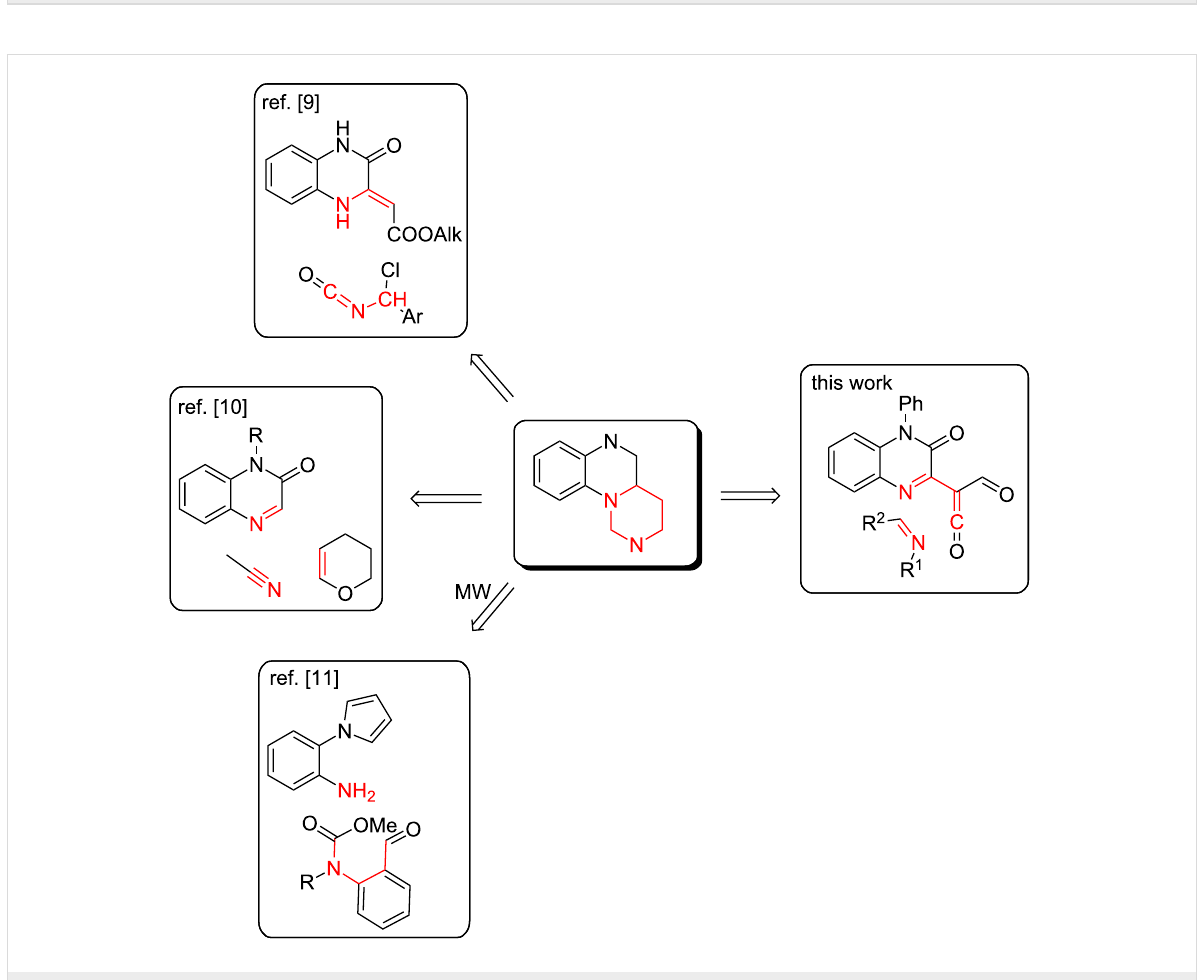
Figure 2: Synthetic routes towards the pyrimido[1,6- a ]quinoxaline